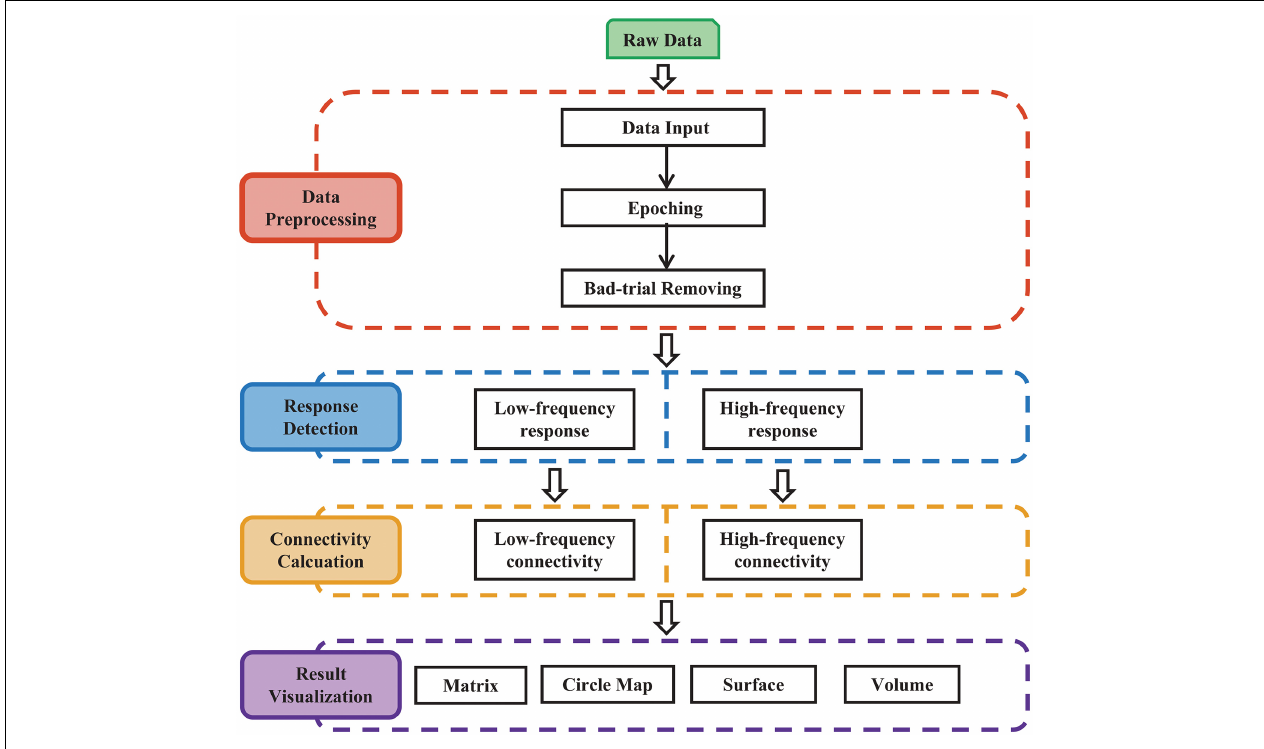
FIGURE 1 | Main procedure for pipeline processing and visualization of responses to electrical stimulation. The procedure includes four parts: (1) data preprocessing; (2) response detection of electrical stimulation; (3) cortico-cortical connectivity calculation; and (4) result visualization.